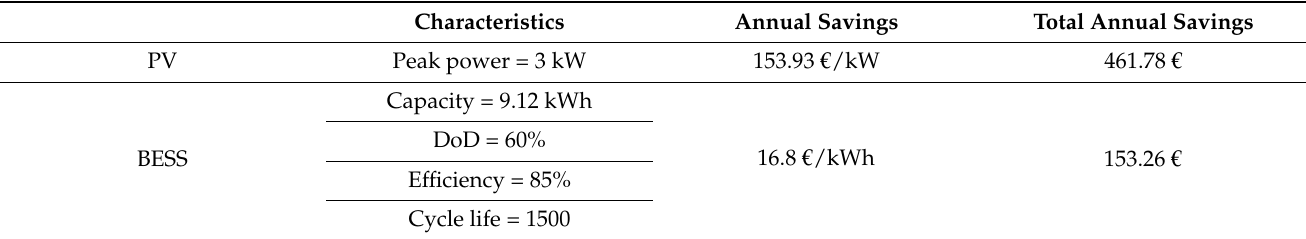
Table 2. Results